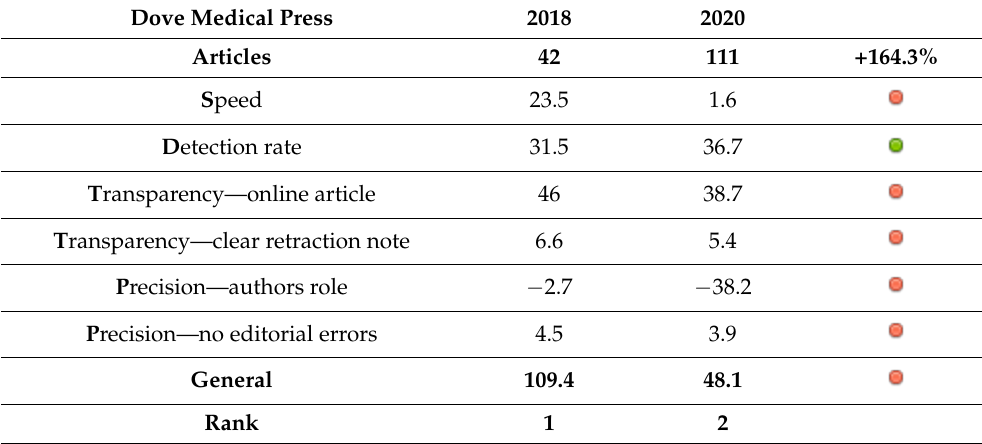
Table 17. Wolters Kluwer 2018 – 2020 change of SDTP score.